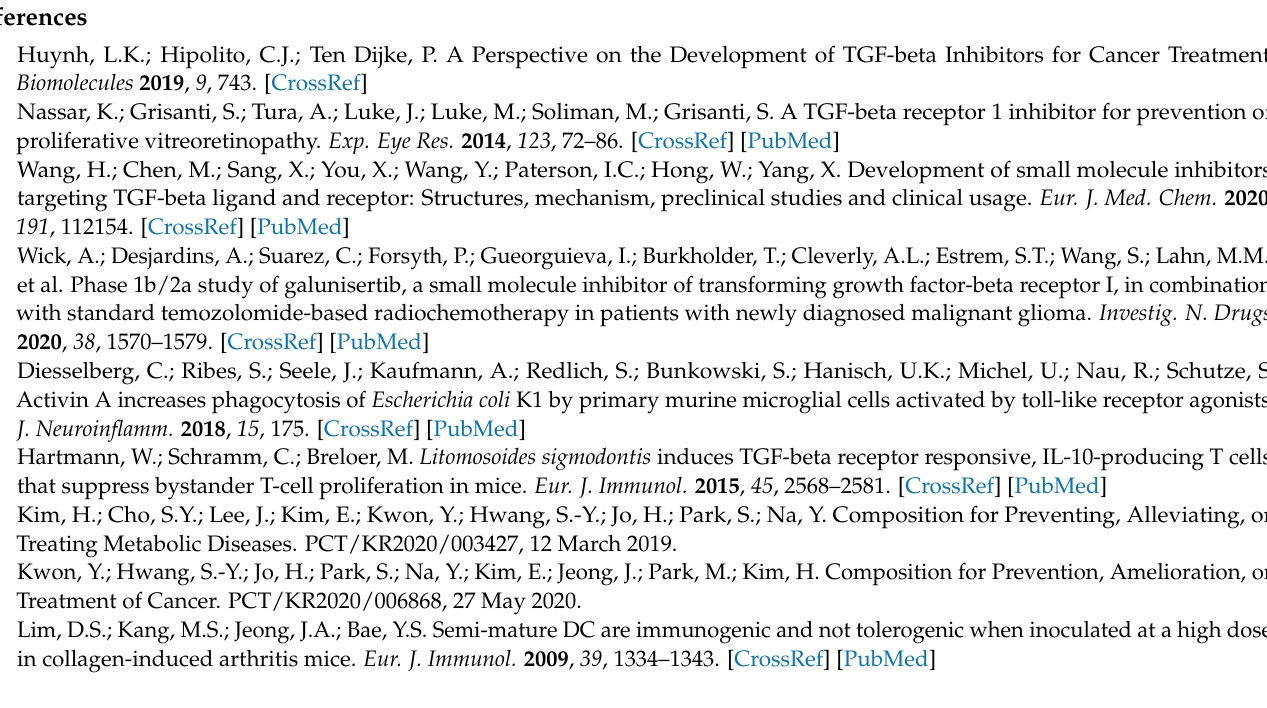
Figure S1: Chemical structure of (E)-1-(3-Aminophenyl)-3-(2,5-dimethoxyphenyl)prop-2-en-1-one (T74), Figure S2: Cell viability and pro-inflammatory cytokine production by using T74 on DCs with various dosed, Figure S3: Histopatho- logical inflammation scoring of H&E-stained